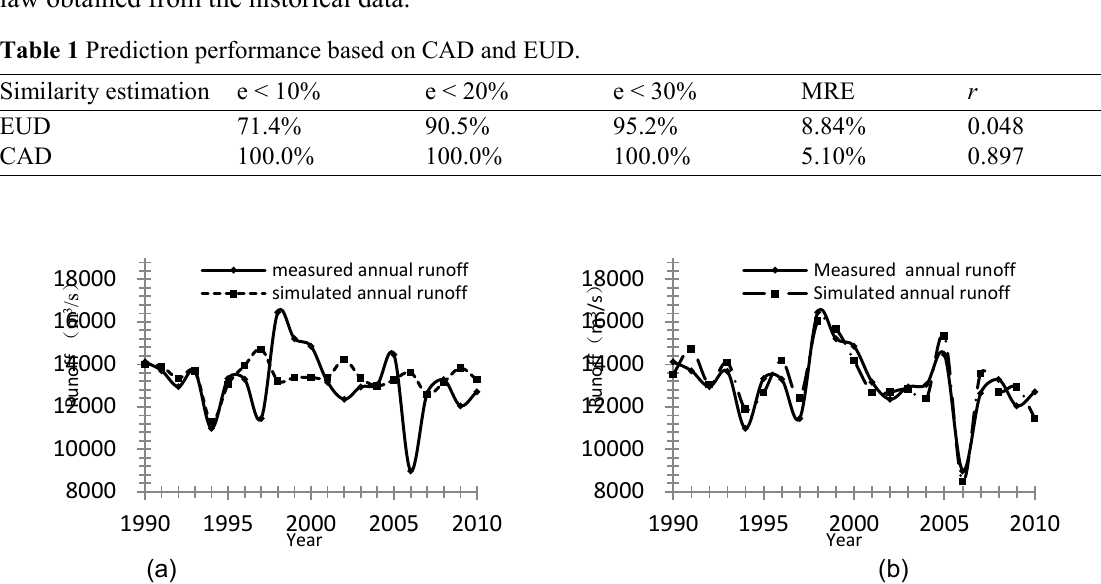
Fig. 4 Comparisons between measured and simulated annual runoff during the period of 1990–2010: (a) model performances with EUD, and (b) model performances with